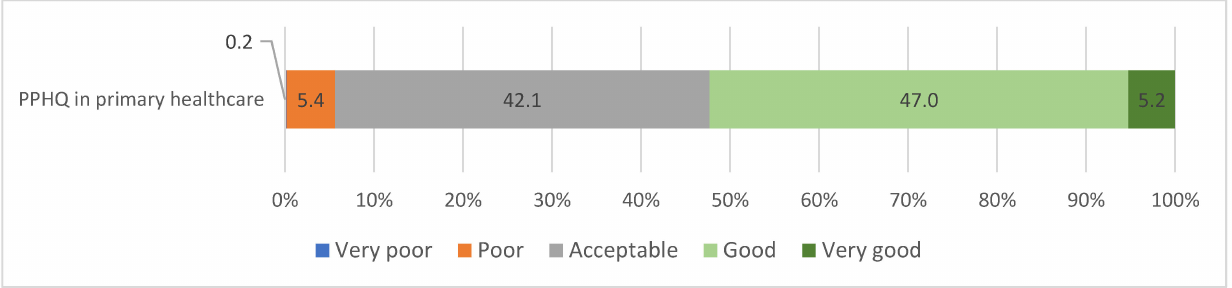
Figure 1. Distribution of responses regarding PPHQ in primary